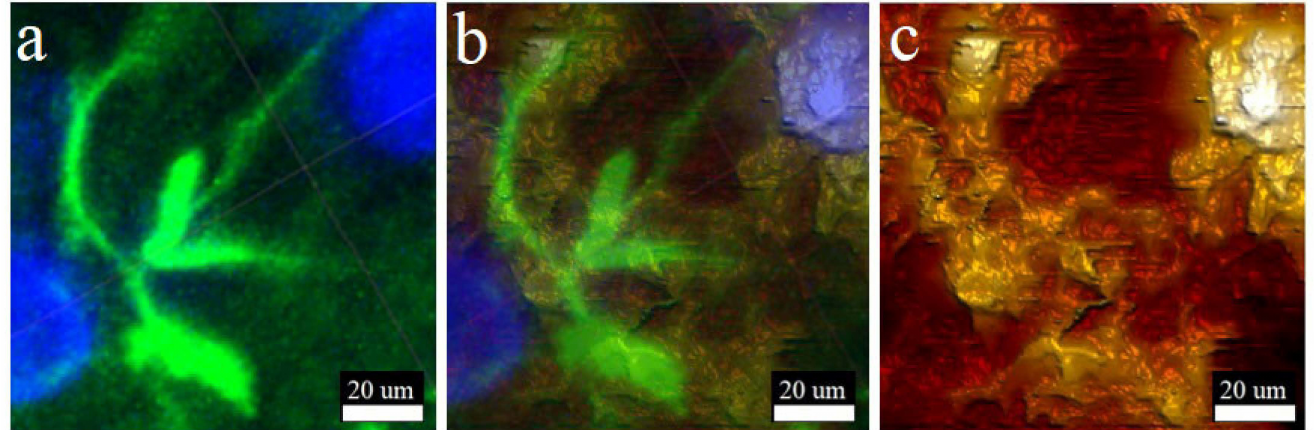
Figure 6. Combined immunohistochemical LSM and AFM analysis of rat brain slices. ( a ) Immunohis- tochemistry of slice surface captured by LSM (blue signal–DAPI-cell nucleus; green signal–GFAP-glial cell cytoskeletal protein); ( b ) merged LSM and AFM channels; ( c ) morphological map of the slice surface obtained by AFM (height